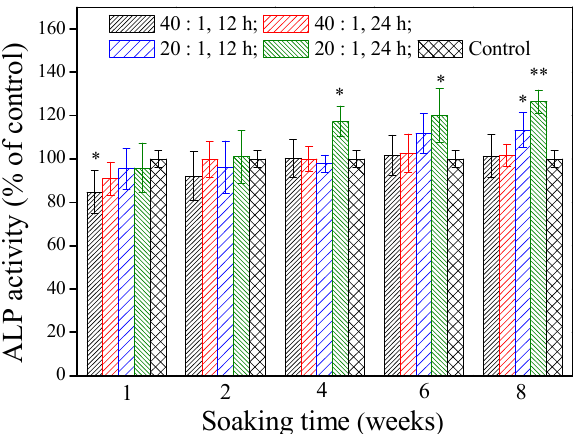
Figure 5. The effect of the γ –PGA/ β –TCP composite fiber extract on the ALP activity of MG-63 cells after 4 days of culture. The results are expressed as a percentage of the control (* p < 0.05 and ** p < 0.01 vs. control).